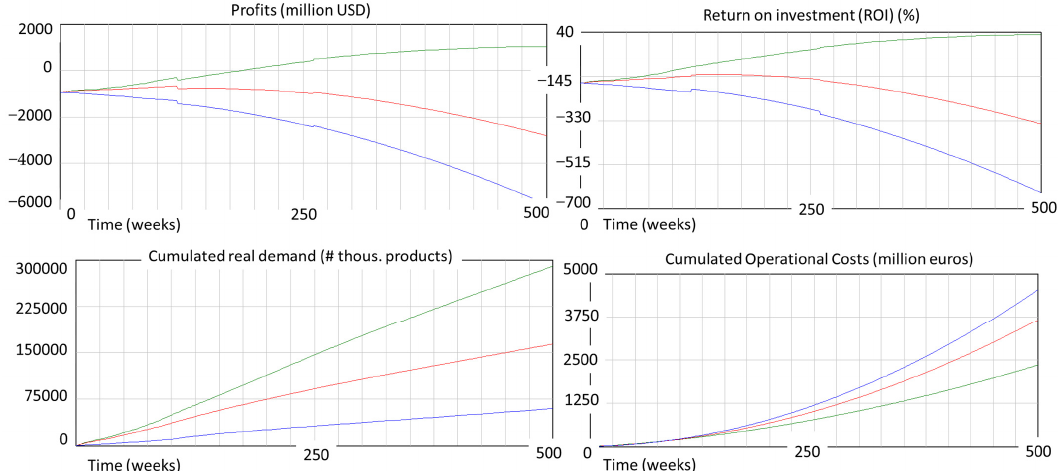
Figure 11. Validation based on extreme-value tests for number of employees (own